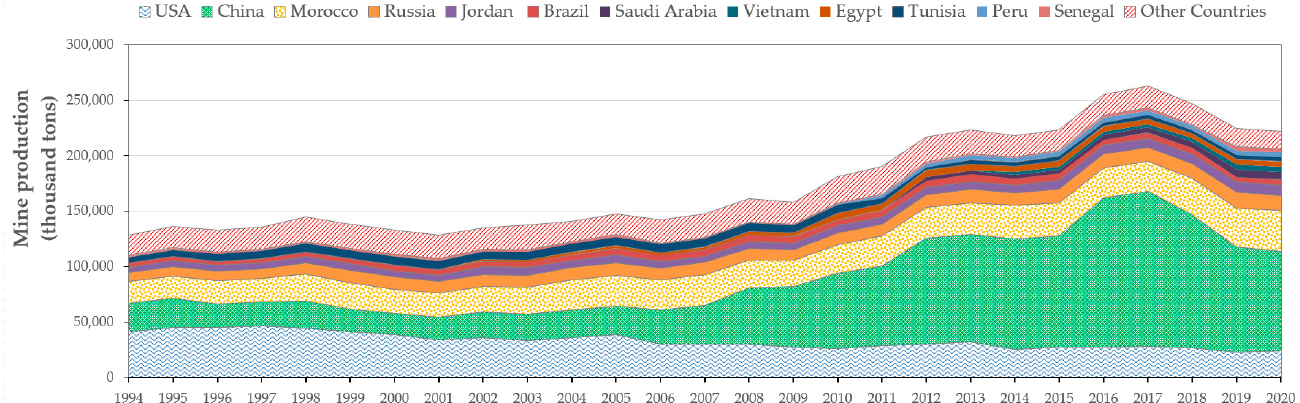
Figure 1. Global phosphate rock reserves (Source: data compiled from USGS database, 1994–2020).